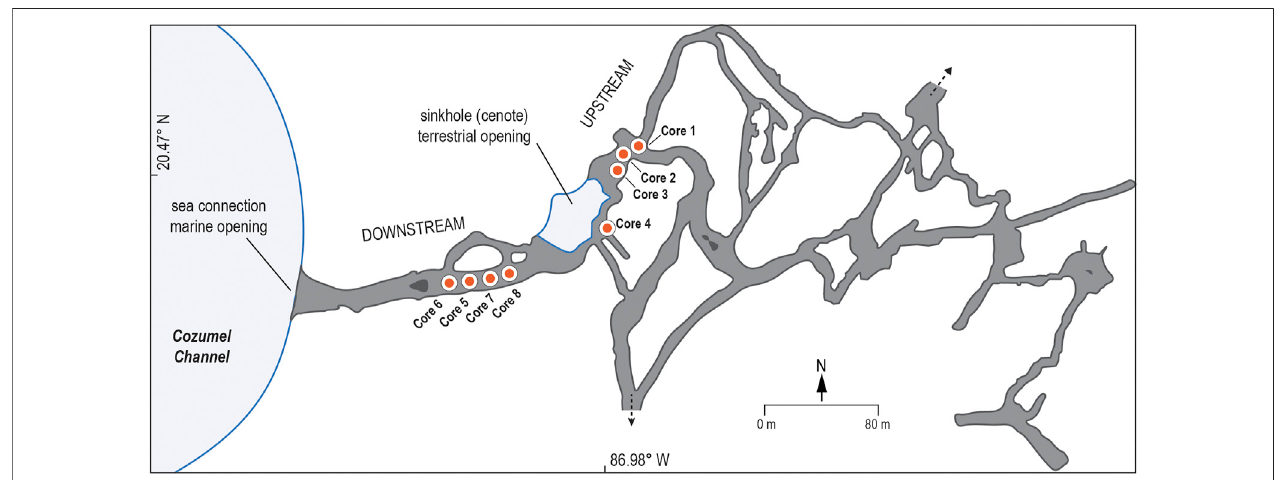
FIGURE 2 | Map of Aerolito Cave in Cozumel Island. Located below sea-level, the cave network promotes seaward material transport and a hydrologically interconnected environment between the sea and the aquifer, providing access to the subterranean estuary. The terrestrial sinkhole opening, colloquially known as Cenote El Aerolito, is partially surrounded by mangroves. Sediment cores (orange circles) were obtained from downstream (Core 5, Core 6, Core 7, and Core 8) and upstream (Core 1, Core 2, Core 3, and Core 4) passages. Map is adapted after Mejía-Ortíz et al. (2007).